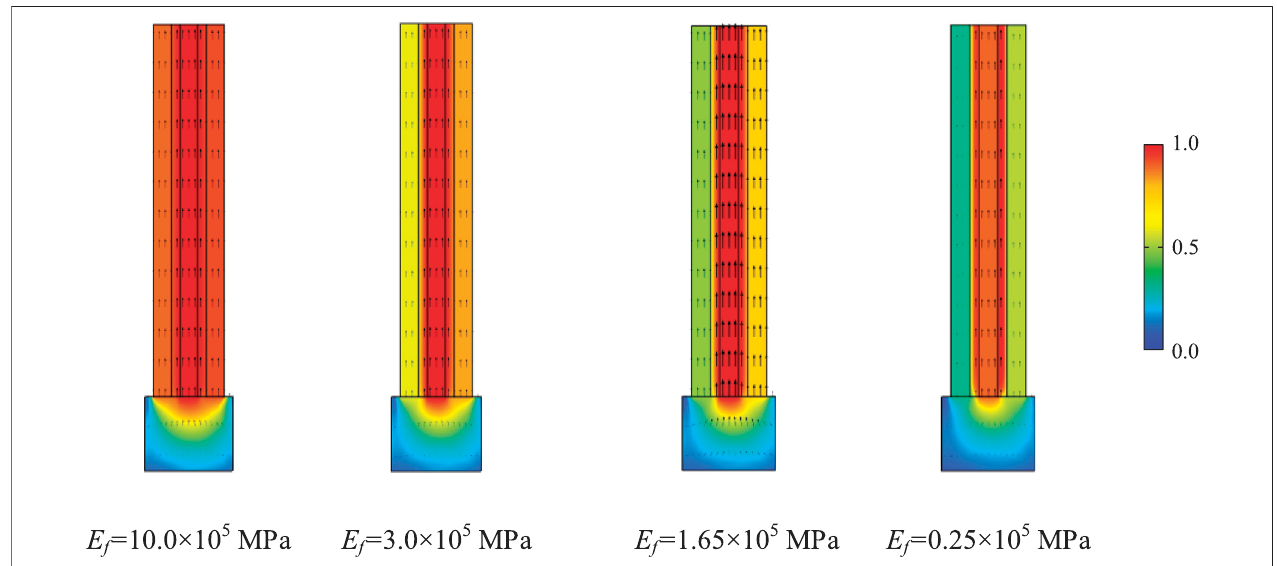
FIGURE 5 | Eigenmode and displacement vector fi eld at point A 3 in rigid foam ring with different elastic modulus E f .